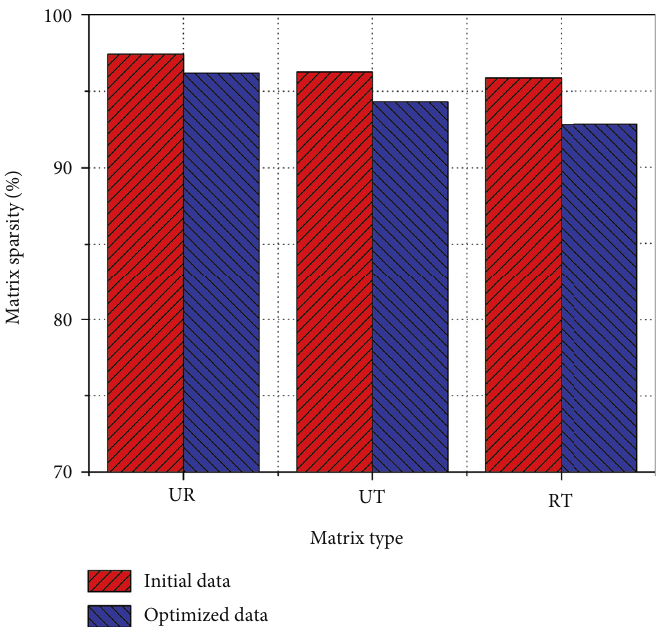
Figure 8: Sparsity comparison of